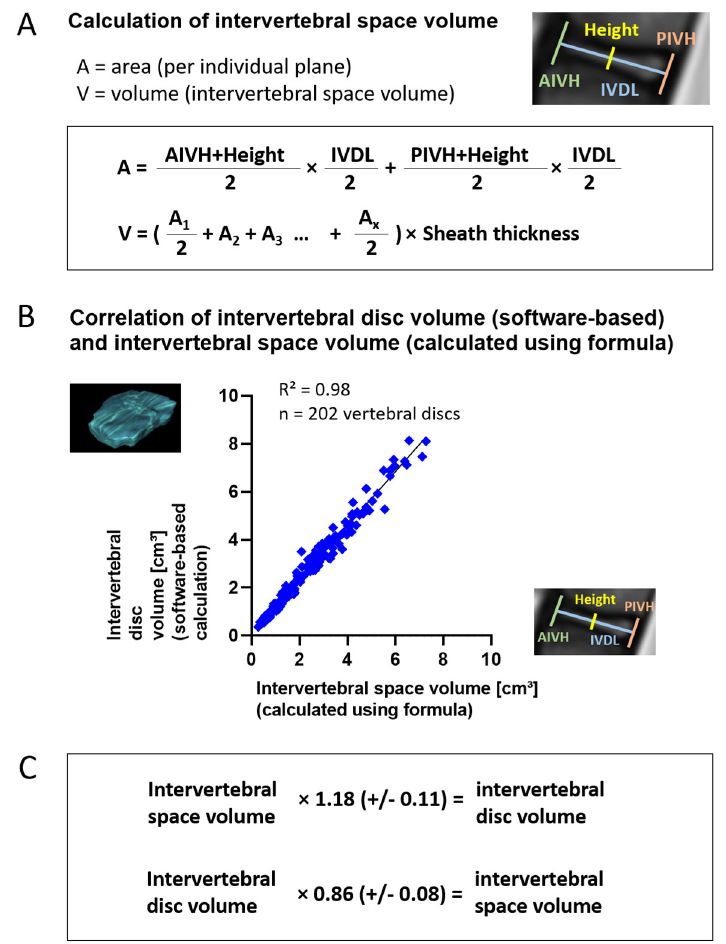
Figure 4. Calculation of intervertebral space volume and correlation with intervertebral disc volume. Intervertebral space dimensions measured as described in Figure 3 were used to calculate the intervertebral space volume using the formula depicted in ( A ). First, the area A of the intervertebral space was calculated for each individual plane using the measured lengths as depicted in Figure 3 and the Trapezoidal rule. Again, using the Trapezoidal rule, the areas of all planes (A1, A2, A3, . . . Ax with x being the number of planes) were subsequently multiplied by the sheath thickness of MRI scans to gain the total intervertebral space volume V. Correlation of intervertebral disc volume (determined by drawing of circumferences and software-based calculation) and intervertebral space volume (determined by landmark measurements and calculation using formula) for 202 intervertebral discs (T4/5, T7/8, T11/12, L1/2-L5/S1) revealed a strong correlation of both methods (R 2 = 0.98) ( B ). On average, the intervertebral disc volume was larger by a factor of 1.18 than the intervertebral space volume, so that 1.18 (+/ − 0.11) may be applied as a correction factor to calculate the intervertebral disc volume from the intervertebral space volume, and a correction factor of 0.86 (+/ − 0.08) may be applied vice versa. ( C ). Given is mean +/ − standard deviation (SD).